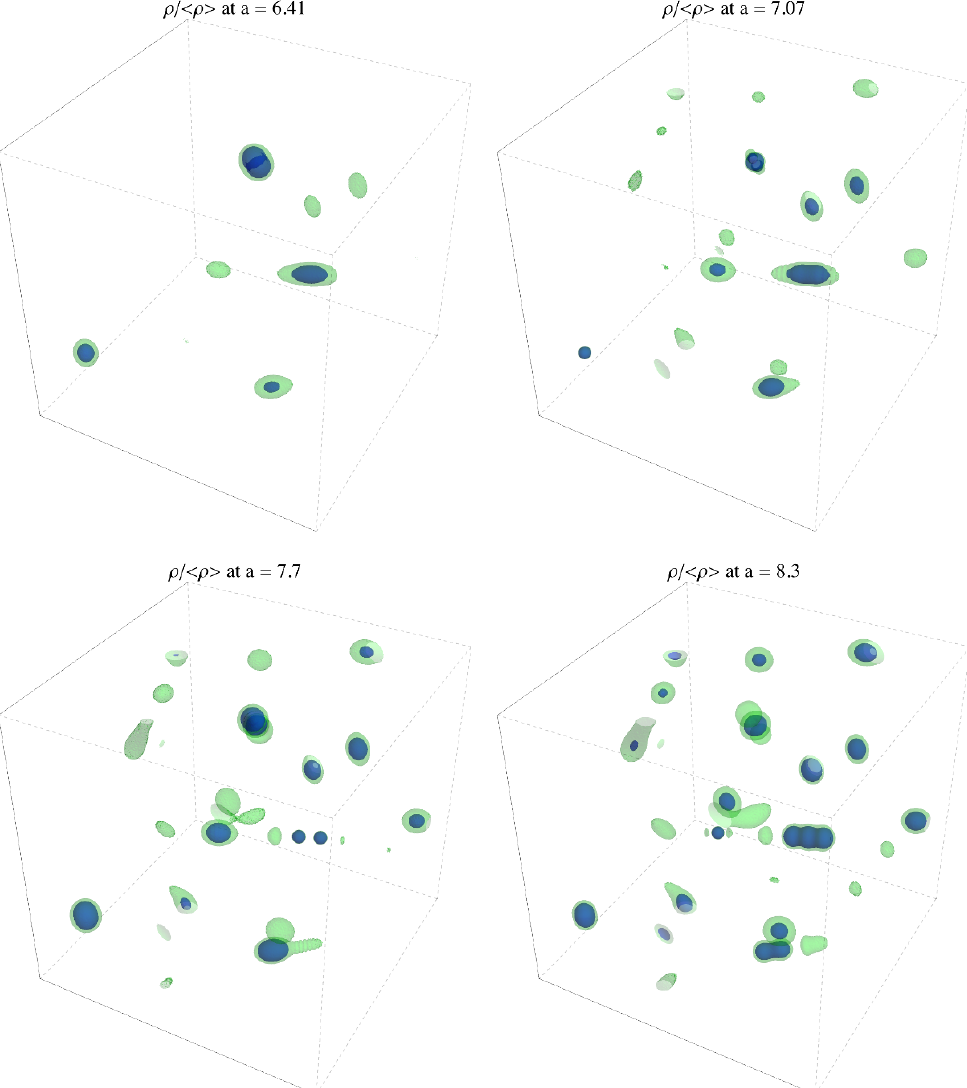
(cid:0) 5 and 512 points 0 = 10